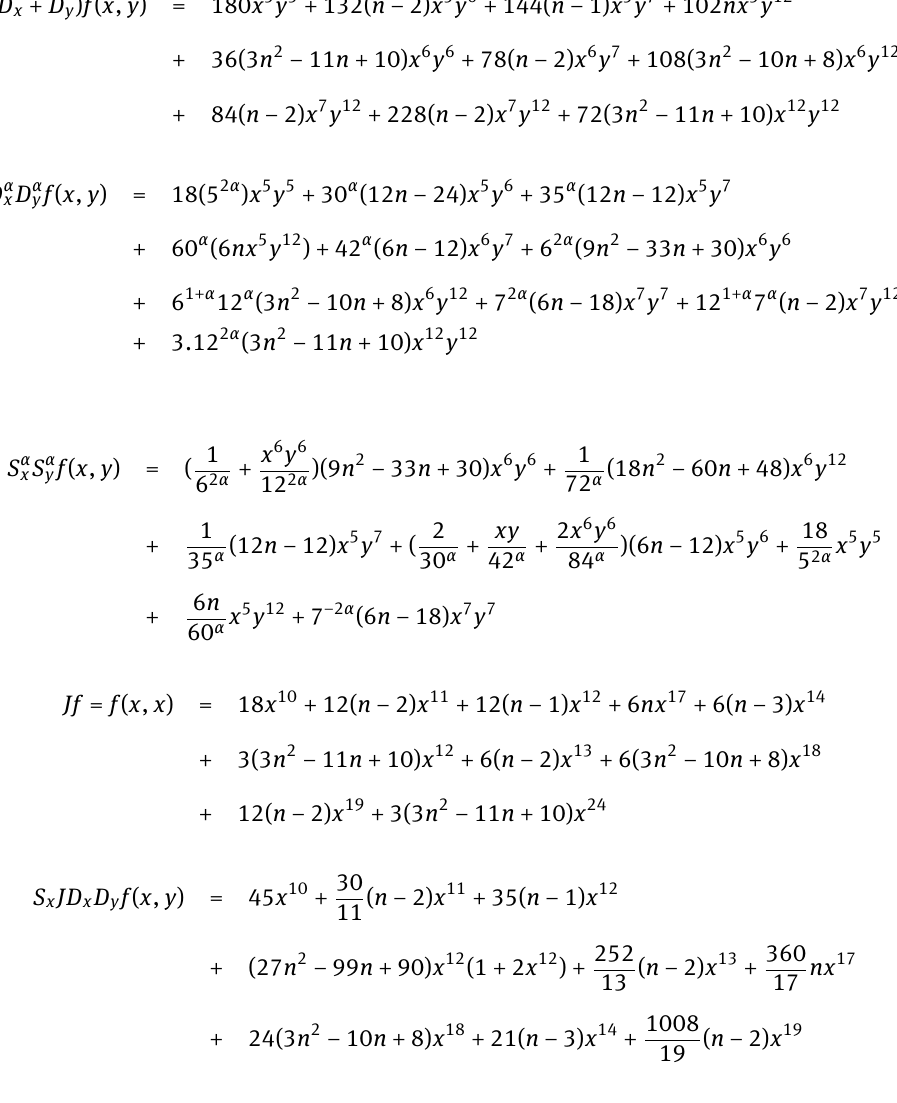
( D + D ) f ( x , y ) = 180 x 5 y 5 + 132( n − 2) x 5 y 6 + 144( n − 1) x 5 y 7 + 102 nx 5 y x y